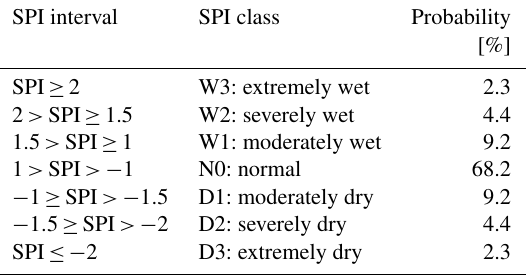
Table 2. Standardized Precipitation Index (SPI) classes with their corresponding SPI intervals and theoretical occurrence probabilities (according to WMO’s SPI User Guide ; Svoboda et al., 2012). SPI interval SPI class Probability